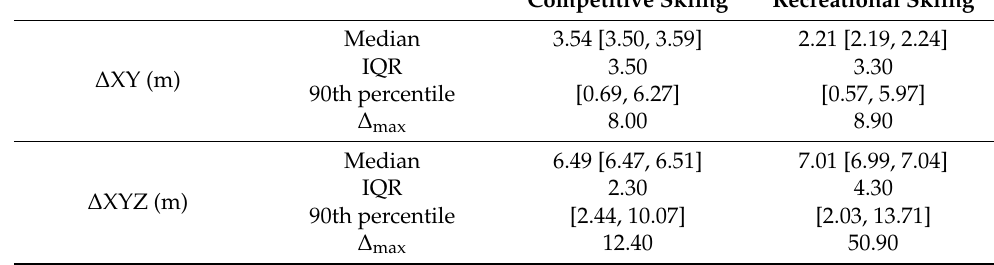
Table 3. Summary of position errors for competitive and recreational skiing data. Errors are re- ported as median with 95% confidence intervals, interquartile range (IQR) and maximal error (Δmax) for position error in the horizontal plane (ΔXY) and position error in three dimensions (ΔXYZ).